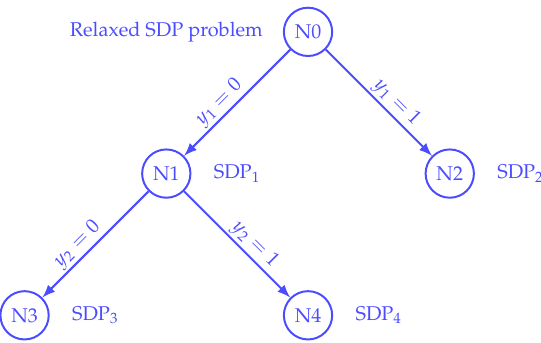
Figure 3. Schematic representation of the B&B method for addressing MI-SDP problems.